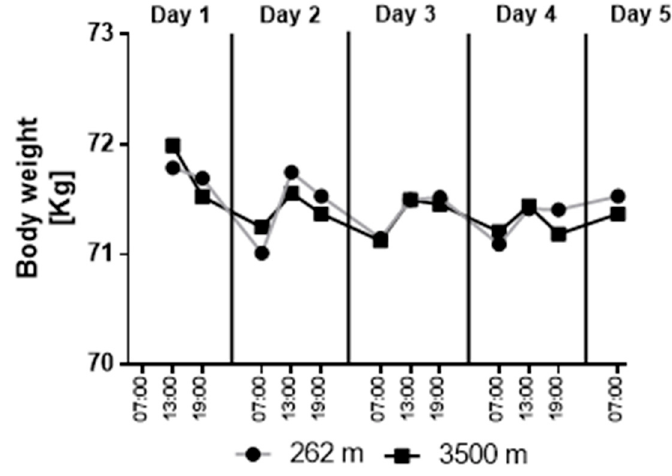
Figure 2. Body weight over time. Data represented as the mean of nine subjects. ANOVA effects: time: <0.001, eta 2 = 0.265; interaction: p = 0.403, eta 2 = 0.061; condition: p = 0.999, eta 2 = <0.001.